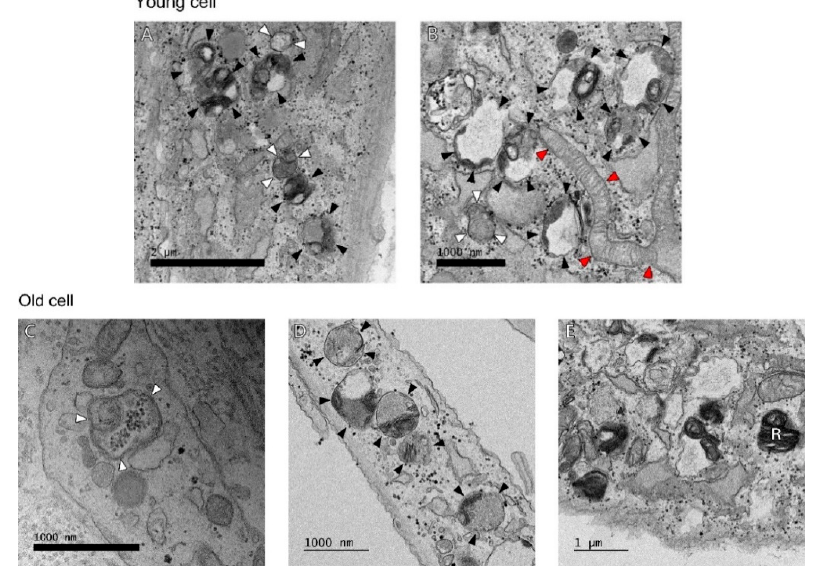
Figure 2 . At the ultrastructural level, Young cell: ( A ) There are a number of autolysosomes (black arrowheads) at early stages of degradation. Different types of material are seen inside. There is already some degradation going on as the multi-membranous structure (called onion-like) is seen, which appears often when degradation is very active. An autophagosome with density similar to the surrounding cytosol and a double membrane (upper white arrowheads) and one with mitochondria inside (lower white arrowheads) are seen, ( B ) This is also an area of high autophagic activity where autophagosome (white arrowheads) and autolysosomes (black arrowheads) at different stages of degradation area seen. There is also a fresh, very long mitochondria fused to the mitochondrial network (red arrowheads). Old cell: ( C ) There is an autophagosome (white arrowheads) with a mitochondria inside. ( D ) A number of autolysosomes (black arrowheads) are seen. ( E ) A residual body (R), a lysosome containing indigestible materials is seen.